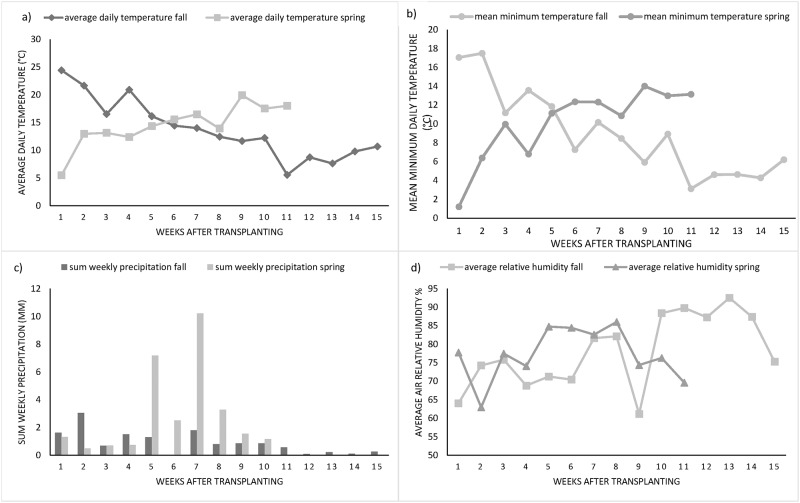
The average daily temperature (a), mean minimum daily temperature (b), sum weekly precipitation (c) and average air relative humidity (d) in the region of Hohenheim during fall 2015 and spring 2016 from transplanting to the end of harvest.